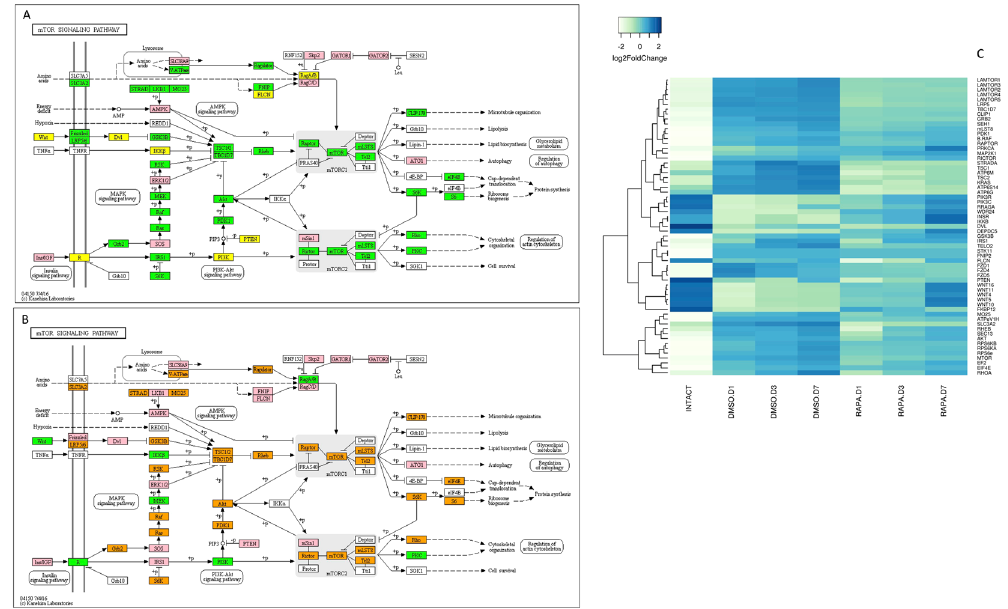
Figure 6. Identification of genes assigned to the mTOR/WNT/AMPK signaling pathway in the G . lateralis YO/I/DRESA transcriptome. In ( A ) and ( B ), KAAS was used to identify genes annotated by BLAST against the specific insect databases (section 4.5) and assigned to a KEGG pathway 38–40 . Uncolored boxes were genes not assigned during annotation. Pink colored boxes represent genes that show no change in expression levels between pairwise comparisons within the 5A and 5B datasets. ( A ) Pairwise comparison of intact/intermolt vs ESA DMSO-control animals. Green colored boxes represent genes up-regulated in premolt (D libraries) relative to intermolt (intact); a yellow color indicates genes down-regulated when entering premolt relative to intermolt. ( B ) Pairwise comparison of ESA DMSO- and Rapamycin-injected animals. Orange colored boxes indicate genes in premolt (D libraries) that decrease in transcript abundance consequent to rapamycin treatment (R libraries); green represents genes normally down-regulated when entering premolt that are now up-regulated by rapamycin treatment. ( C ) Heat map showing the log2-fold change of the FPKM values of the